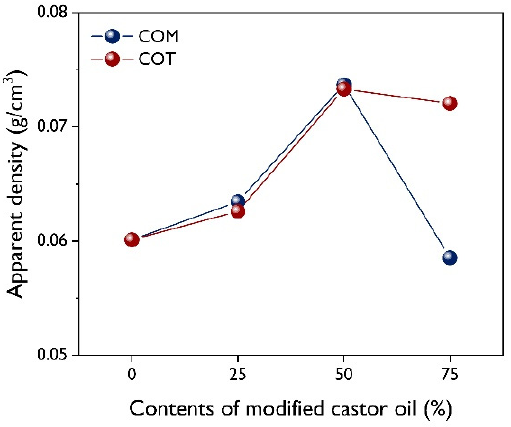
Figure 5. Effect of modified castor oil contents on the density of obtained PU foams.